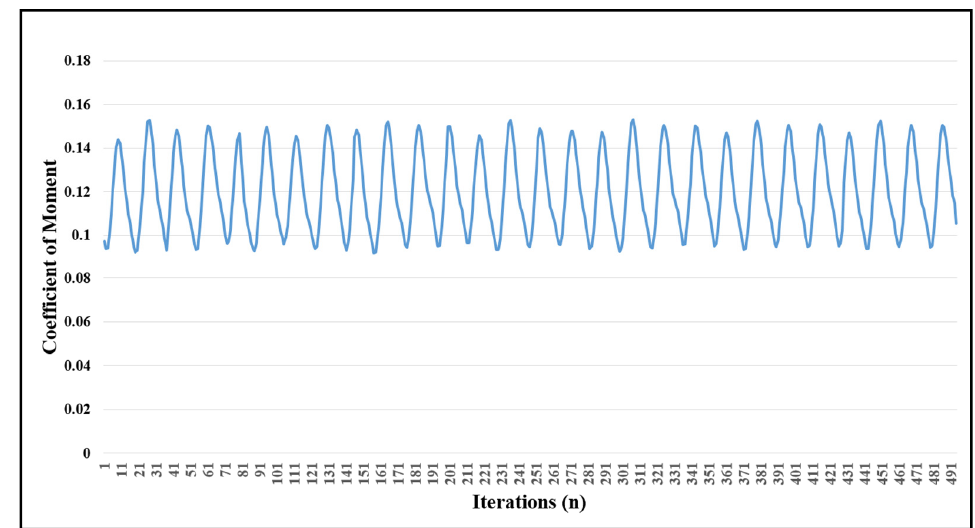
Figure 13. Graphical representation of the coefficient of momentum. Table 4. Printing parameters of 3D printer.